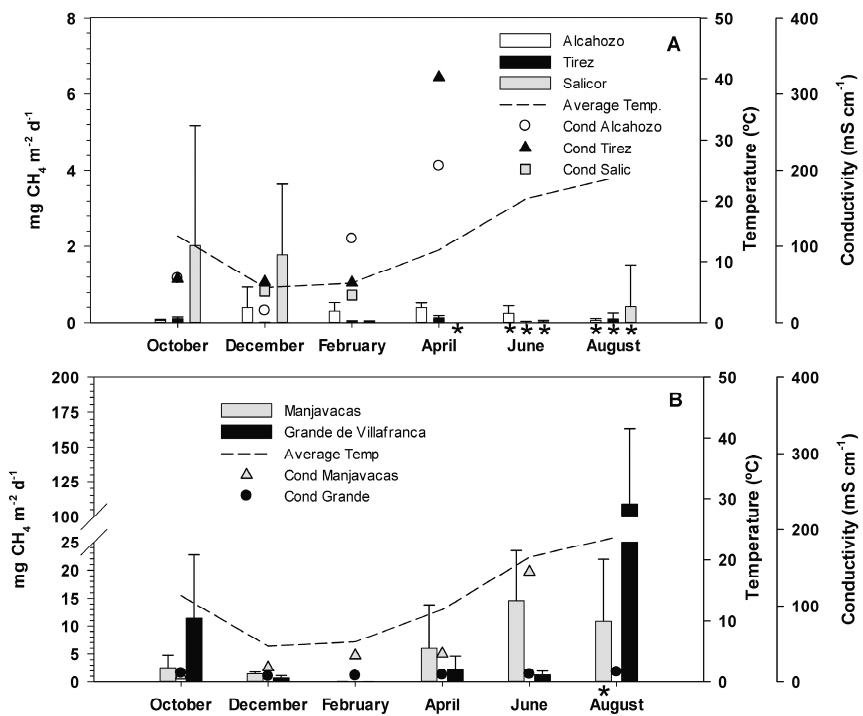
Figure 2. Methane release rates of the studied lakes during a hydrological cycle ( A ) Hypersaline lakes ( B ) Hydrologically altered lakes. Rates are average of 12 replicates. Average temperature at the nearest meteorological station, as well as the water electrical conductivity (as a proxy for salinity) for each lake at each sampling date are given. * indicates that this lake was dry at this sampling event, though the sediments could eventually be wet.